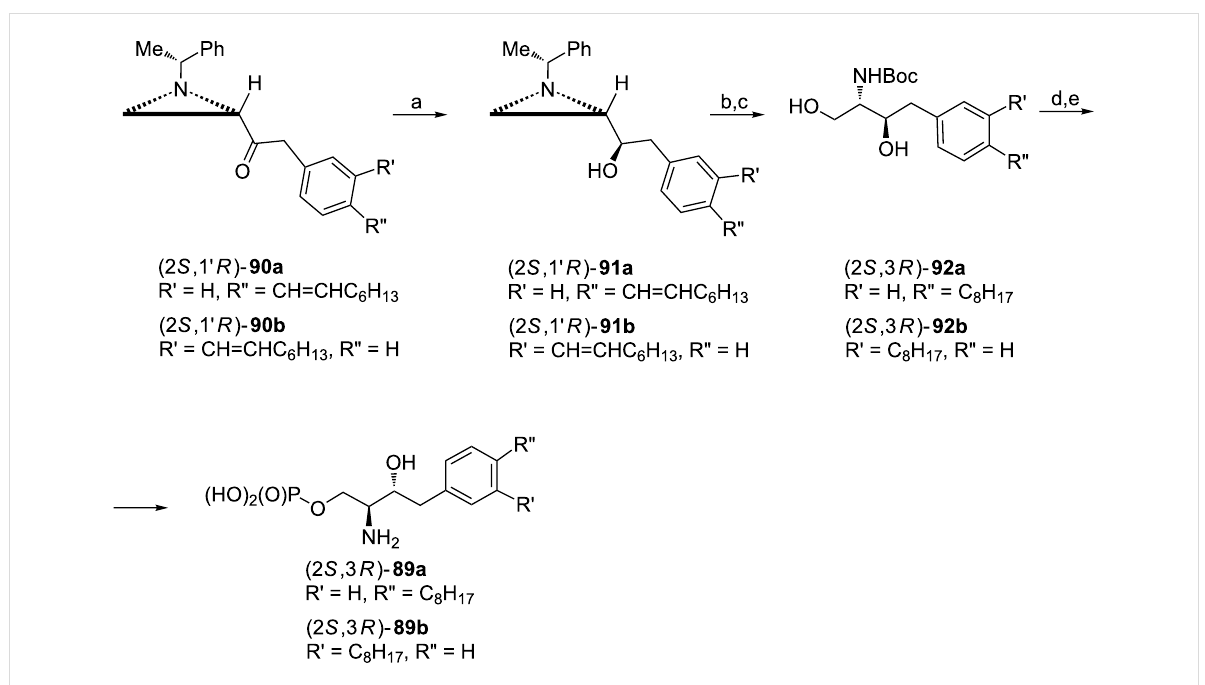
Scheme 23: Synthesis of sphingosine-1-phosphate analogues DS-SG-44 and DS-SG-45 (2 S ,3 R )- 89a and (2 S ,3 R )- 89a . Reagents and conditions: a) NaBH